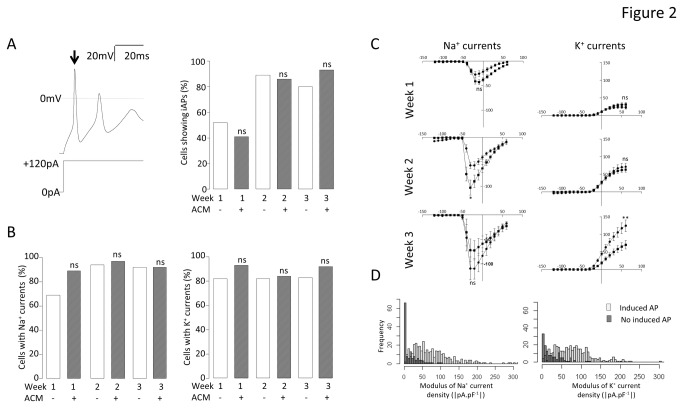
Effect of ACM on iAPs and voltage-gated Na+ and K+ currents of iPSC-derived neurons .A. Exemplar voltage recording (upper left) during a current injection of 120 pA (lower left) from a holding current which maintained Vm at ca. -70mV. Arrow indicates iAP. Right panel shows the comparison of the proportion (%) of control (ACM-) and ACM-treated (ACM+) cells which could be induced to fire an action potential by the current-step protocol at each week of differentiation. Chi2 tests were performed at each week to compare control medium (ACM-) and ACM-treated (ACM+) iPSC-derived neurons. n
snot significant; n = 122. B. Bar graphs comparing the proportion of cells (%) demonstrating voltage-activated Na+ (left) or K+ (right) currents in response to a voltage-step protocol. Chi2 tests were performed as in A, above. n
snot significant; n = 106. C. Mean Na+ current density (left) and K+ current density (right) versus voltage plots (Vh = -70mV) for control (circles) and ACM-treated (squares) cells during 3 weeks of differentiation. T-tests were performed to compare the mean maximal current densities of cells in control medium and ACM-treated cells at each week. *P < 0.05, **P < 0.01, nsnot significant; n = 106.D. Frequency histograms representing the number of cells within set ranges (5 pA.pF
-1) of Na+ (left) and K+ (right) current densities for all neurons. Open bars represent neurons with iAPs and filled bars represent all neurons without iAPs (n = 818).